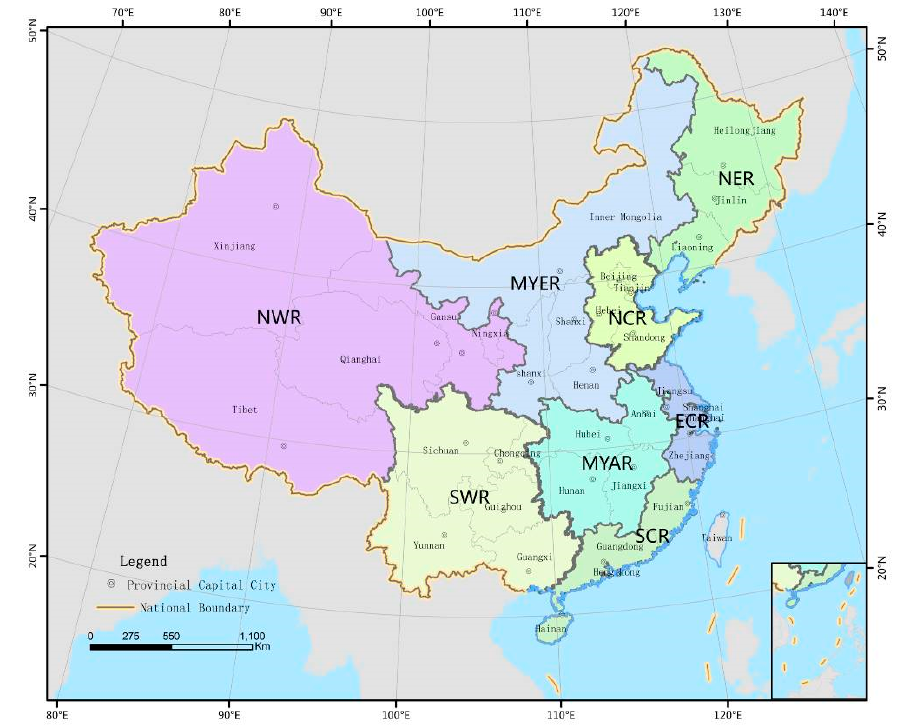
Figure 1. Study area division. ( a ) northern coastal region (NCR); ( b ) eastern coastal region (ECR); ( c ) southern coastal region (SCR); ( d ) middle Yangtze River region (MYAR); ( e ) southwest region (SWR); ( f ) northeast region (NER); ( g ) middle Yellow River region (MYER); ( h ) northwest region (NWR).